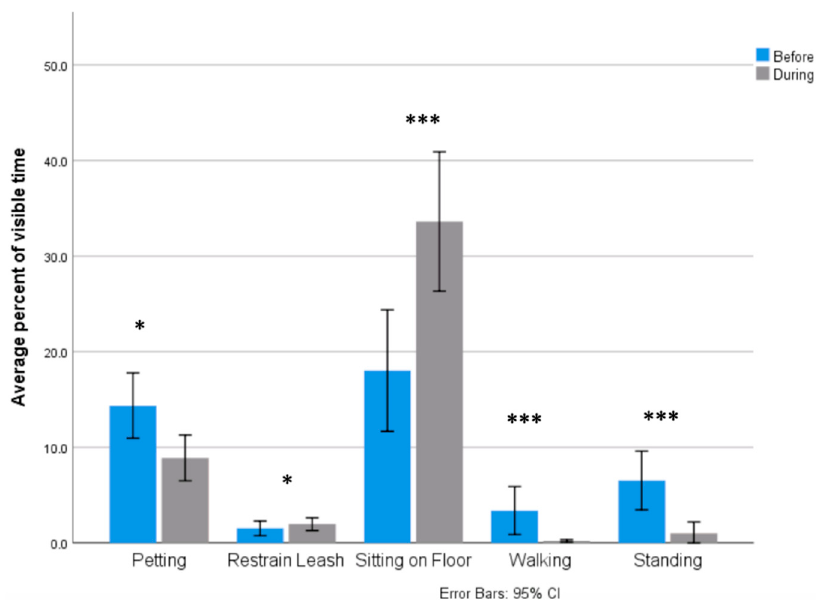
Figure 1. Significant increases in percent visible time spent displaying several behaviors before and during student interaction. * Significant at the 0.05 level. ** Significant at the 0.01 level *** Significant at the 0.001 level.